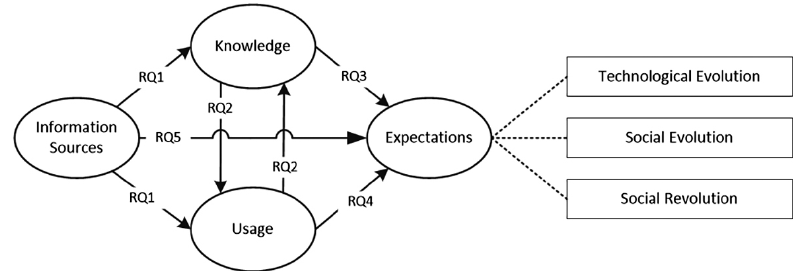
Figure 2. The Emerging Technologies Expectations Model applied to the blockchain